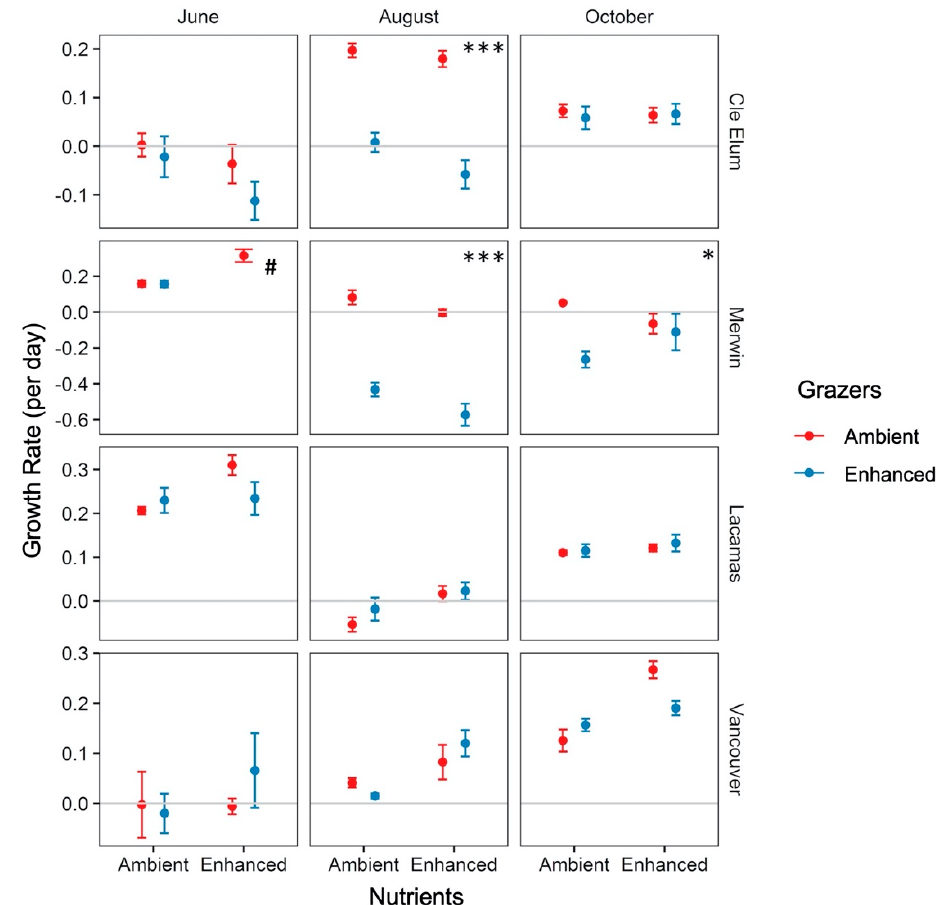
Figure 6. Phytoplankton chl a -based net growth rates (mean ± SE), resulting from two-factorial grazing and nutrient enhancement experiments conducted for Cle Elum, Merwin, Lacamas, and Vancouver lakes in June, August, and October 2014. Significant result of enhanced grazers, measured by 2-way ANOVA, noted with asterisks (*) for experiments conducted in August for Merwin and Cle Elum, and in October for Merwin. Significant result of enhanced nutrients detected by 1-way ANOVA among treatments noted with hashtag (#) for the experiment in June for Merwin. * or # = p < 0.05; *** = p < 0.001. Table 2. Results of nested two-way ANOVAs testing the effect of enhanced grazers and enhanced separately for each month and utilized linear mixed effects methods to include nesting within